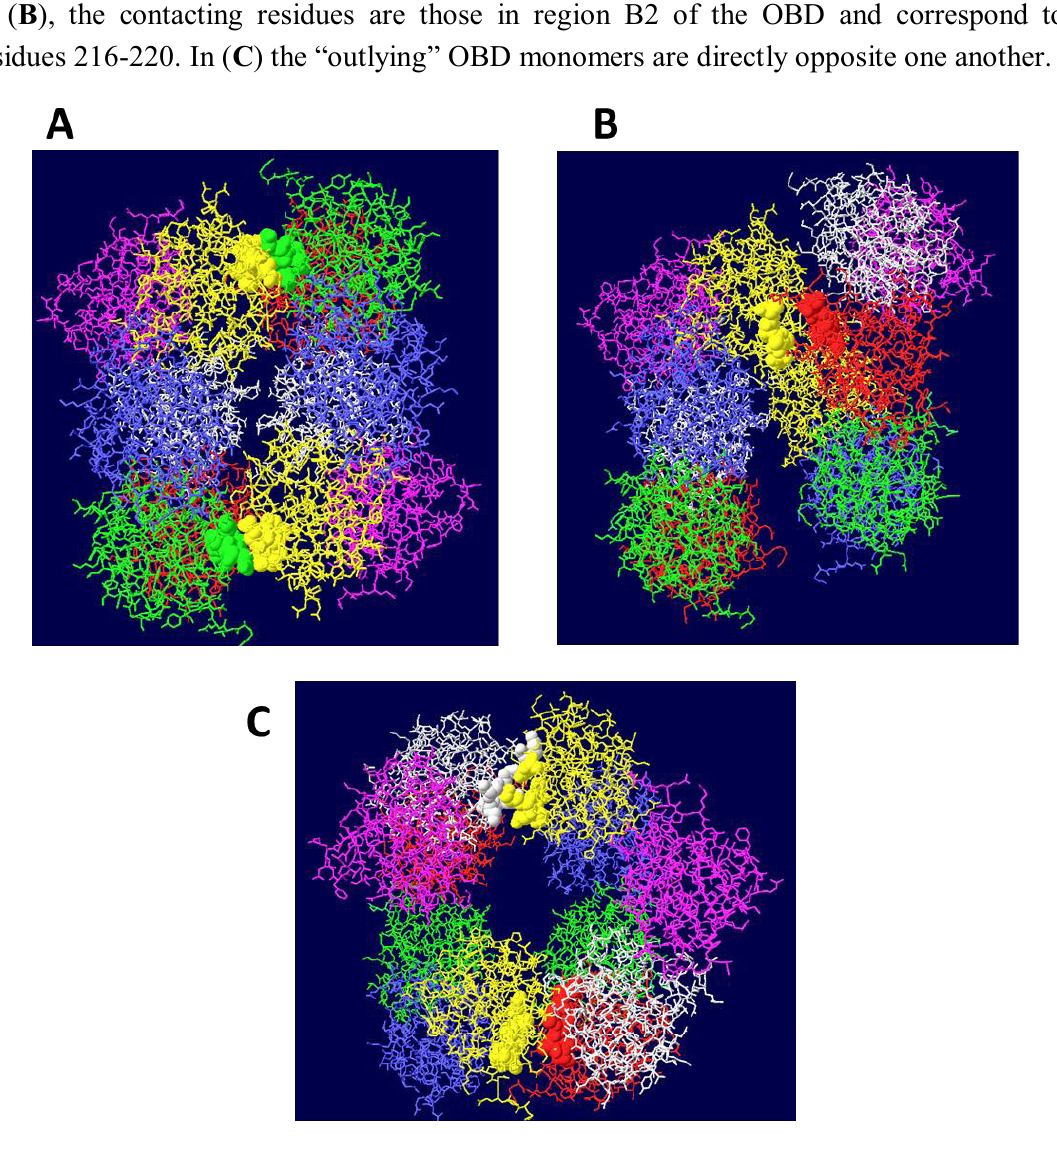
Figure 1. Side views of three different models of OBD hexamer-hexamer stacking. In ( A